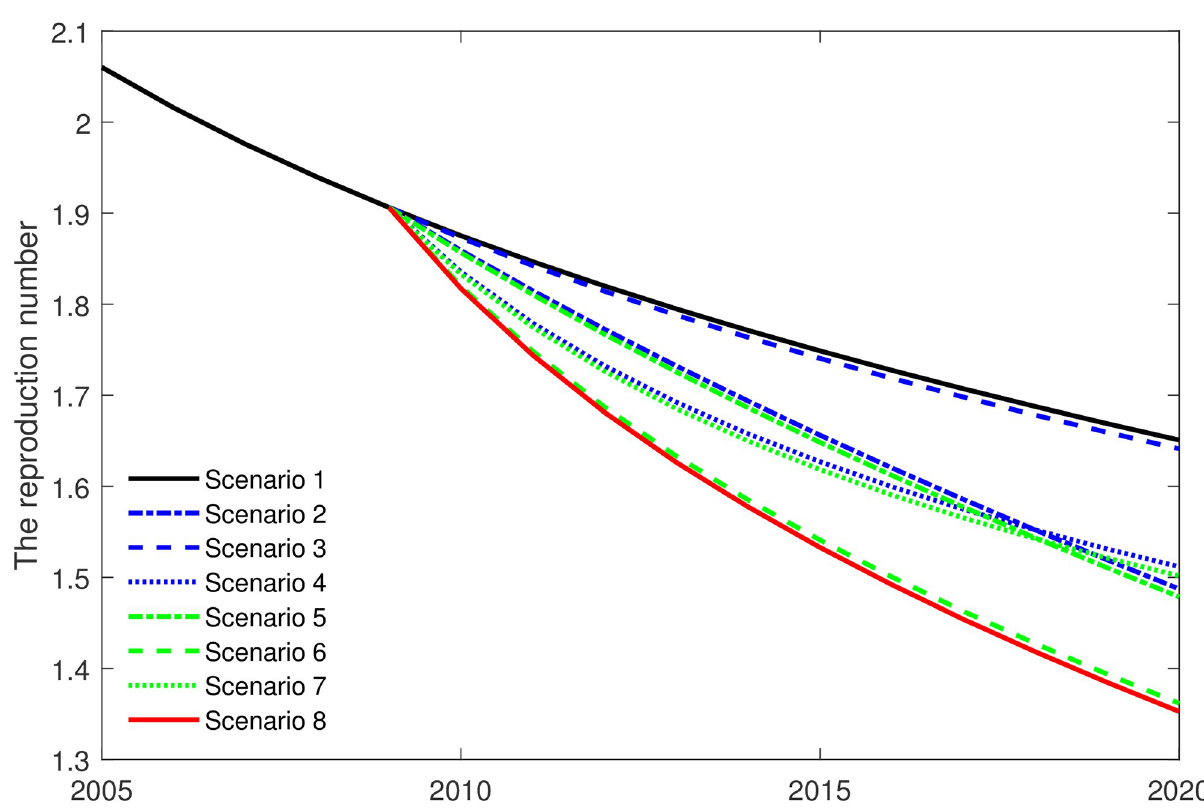
Fig 8. Estimation of the impact of various implementation scenarios on the value of the reproduction number R C . The maximum reduction (to 1.3527) and the minimum reduction (to 1.6413) of R